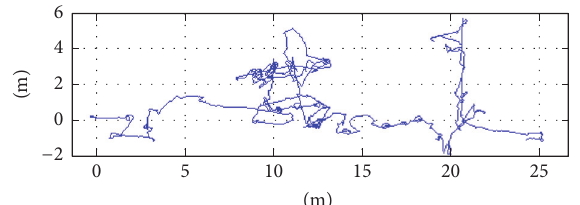
Figure 15: The robot route resolved through keyframes global map and content-based image matching.